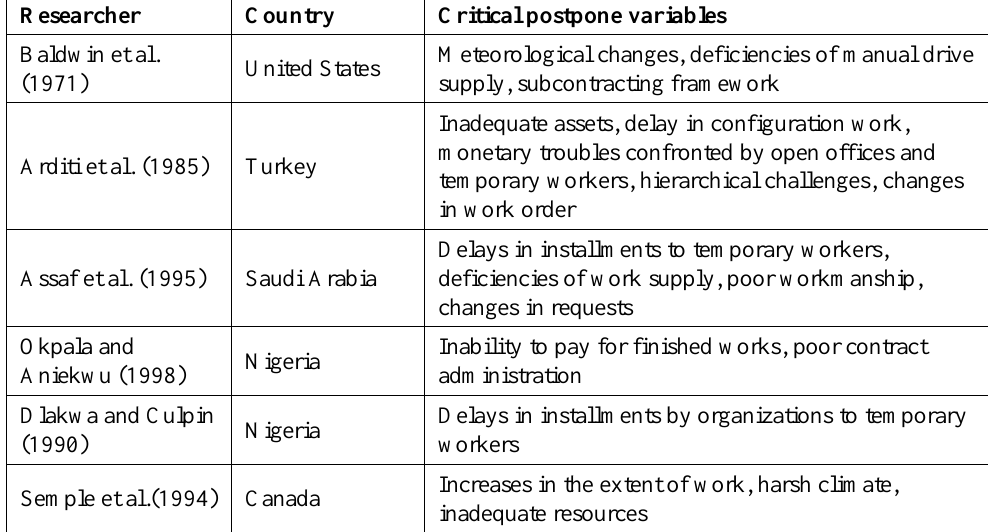
Table 1. Outline of Past Investigation of the Origin of Delays in Construction